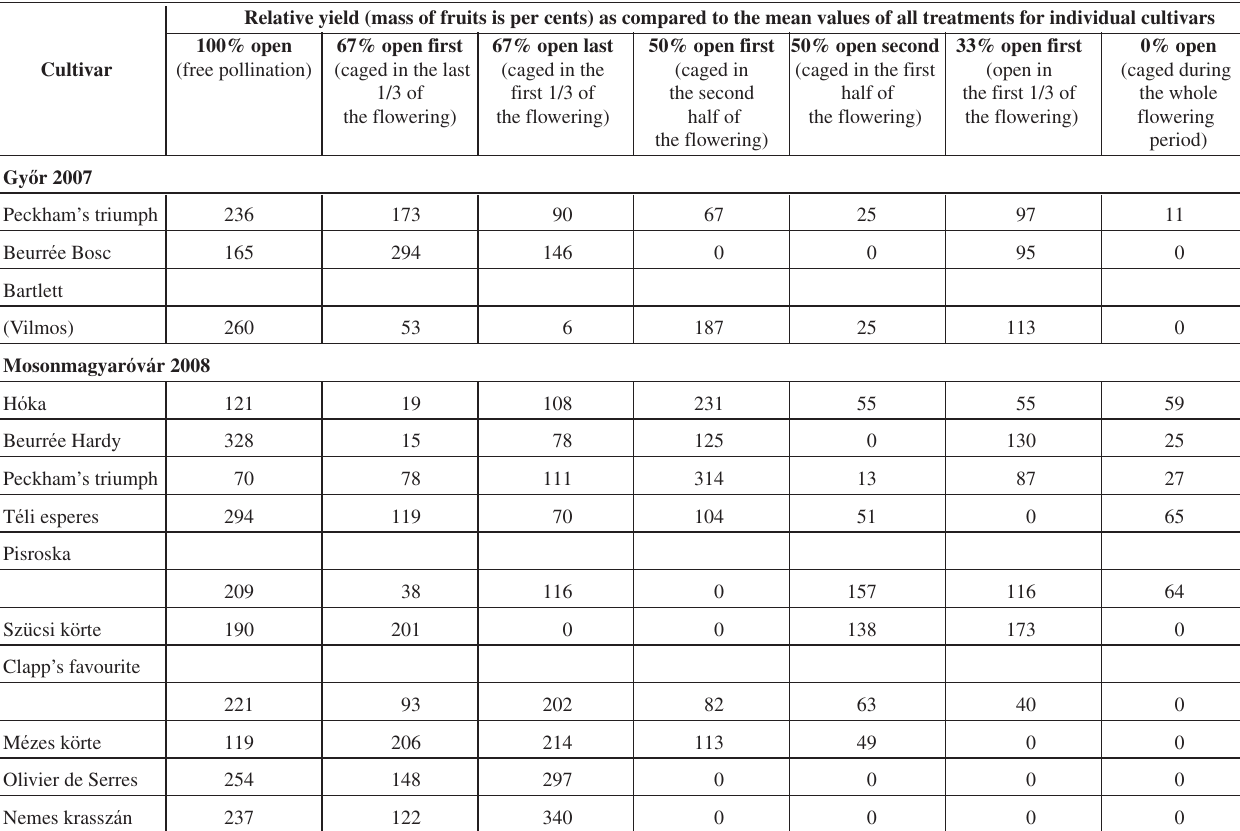
Table 3. Yield of pear cultivars as affected by reduced bee pollination period Relative yield (mass of fruits is per cents) as compared to the mean values of all treatments for individual cultivars